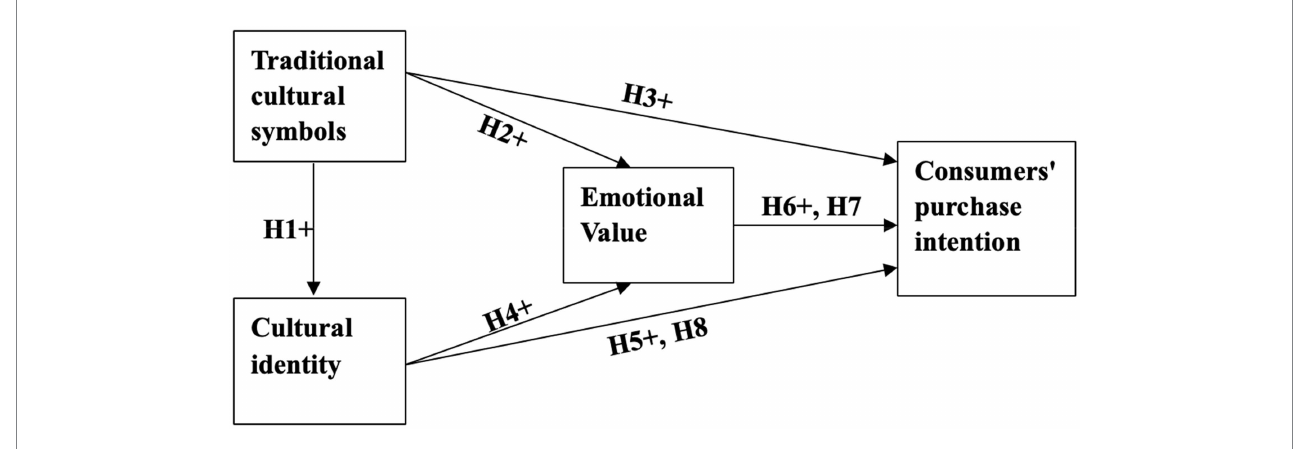
FIGURE 1 Conceptual model of traditional culture on purchase